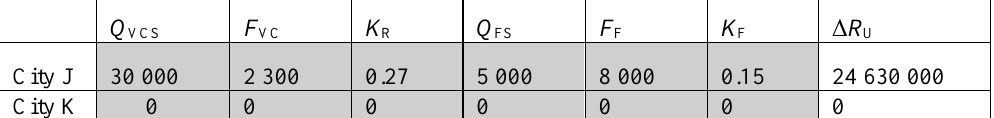
Table 2. Additional Calculation of the Revenue from Growing Number of